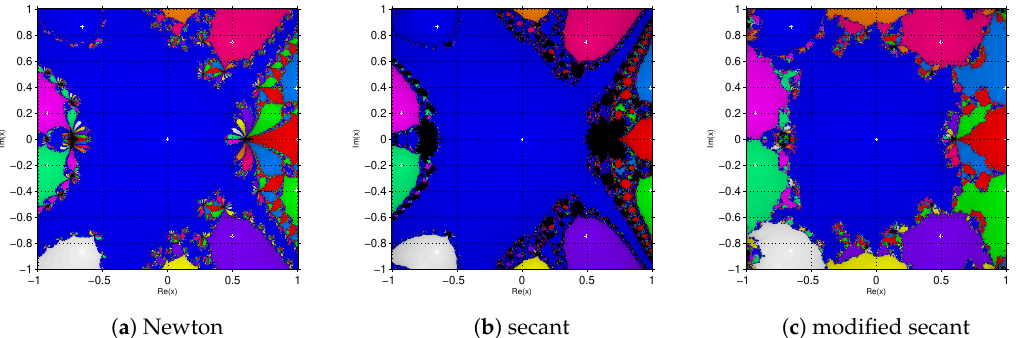
Figure 3. Dynamical planes for f 2 ( z ) = ( z − 1 )( z 10 + z 3 + 1 ) sin ( z ) .